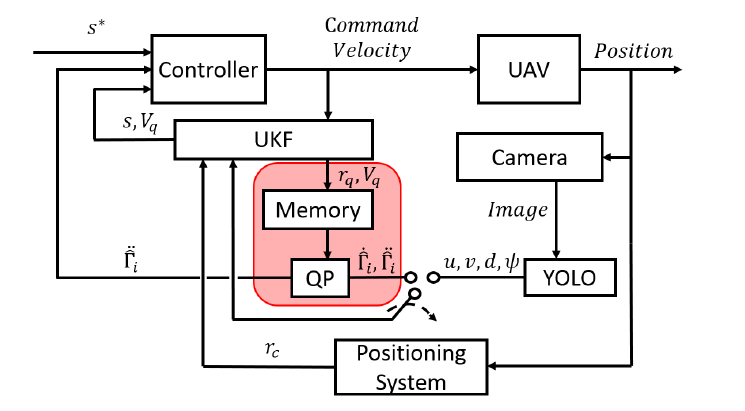
Figure 4. Block diagram of the controller, where u , v , d , and ψ are the measurements being updated using the